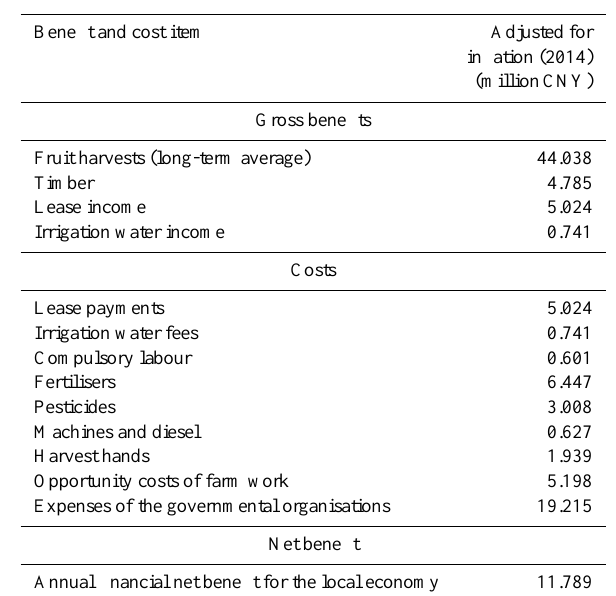
Table 8. Annual benefits and costs of Kökyar I from the perspective of local economy.